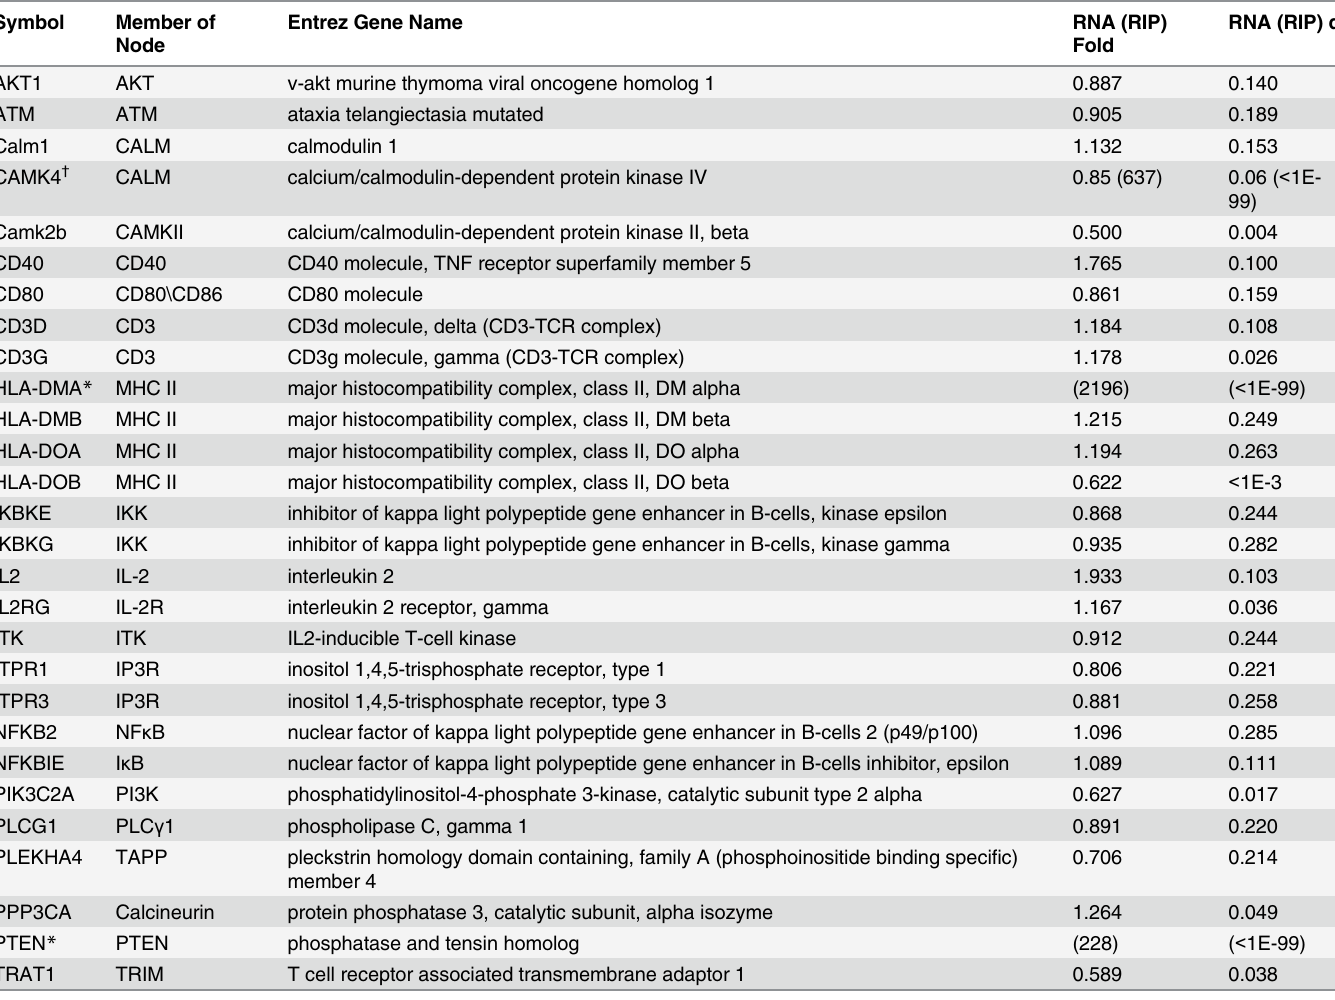
Table 5. Details of the hits in the top canonical pathway (iCOS-iCOSL Signaling in T Helper Cells). Official symbols of the significant genes found via RNA-Seq (RIP-Seq) that are in the pathway (Fig 2) is given along with name of its corresponding node in the pathway. Fold is given as KO/CTL (RNA-Seq) or IP/CTL (RIP-Seq), and q is the false discovery rate value based on method of Benjamini-Hochberg. Genes were identified by both RNA-Seq and RIP-Seq. Numbers in parentheses and italicized denote data obtained from